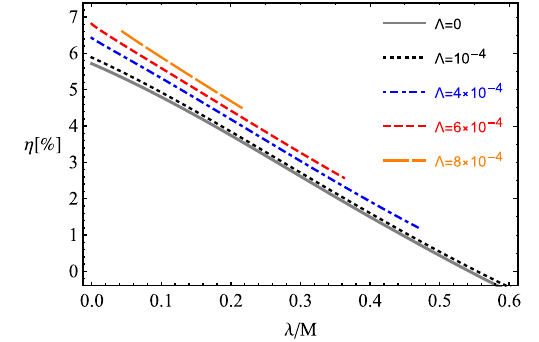
Fig. 7 Efficiency of energy release from accretion disc around Schwarzschild BH surrounded by PFDM in de Sitter as a function of the parameter λ for the different values of Λ . In this plot, we use Λ → Λ/ M 2